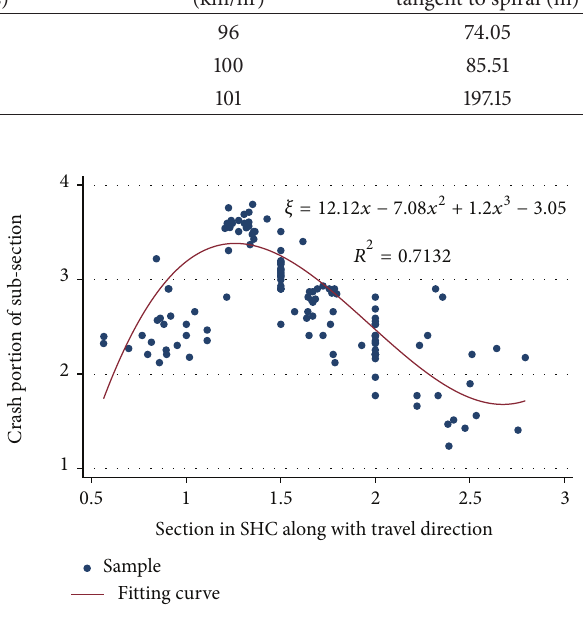
Table 2: Drivers’ instantaneous changes of heart rate, occurrence position, and operating speed before entering SHCs. Radius (m)